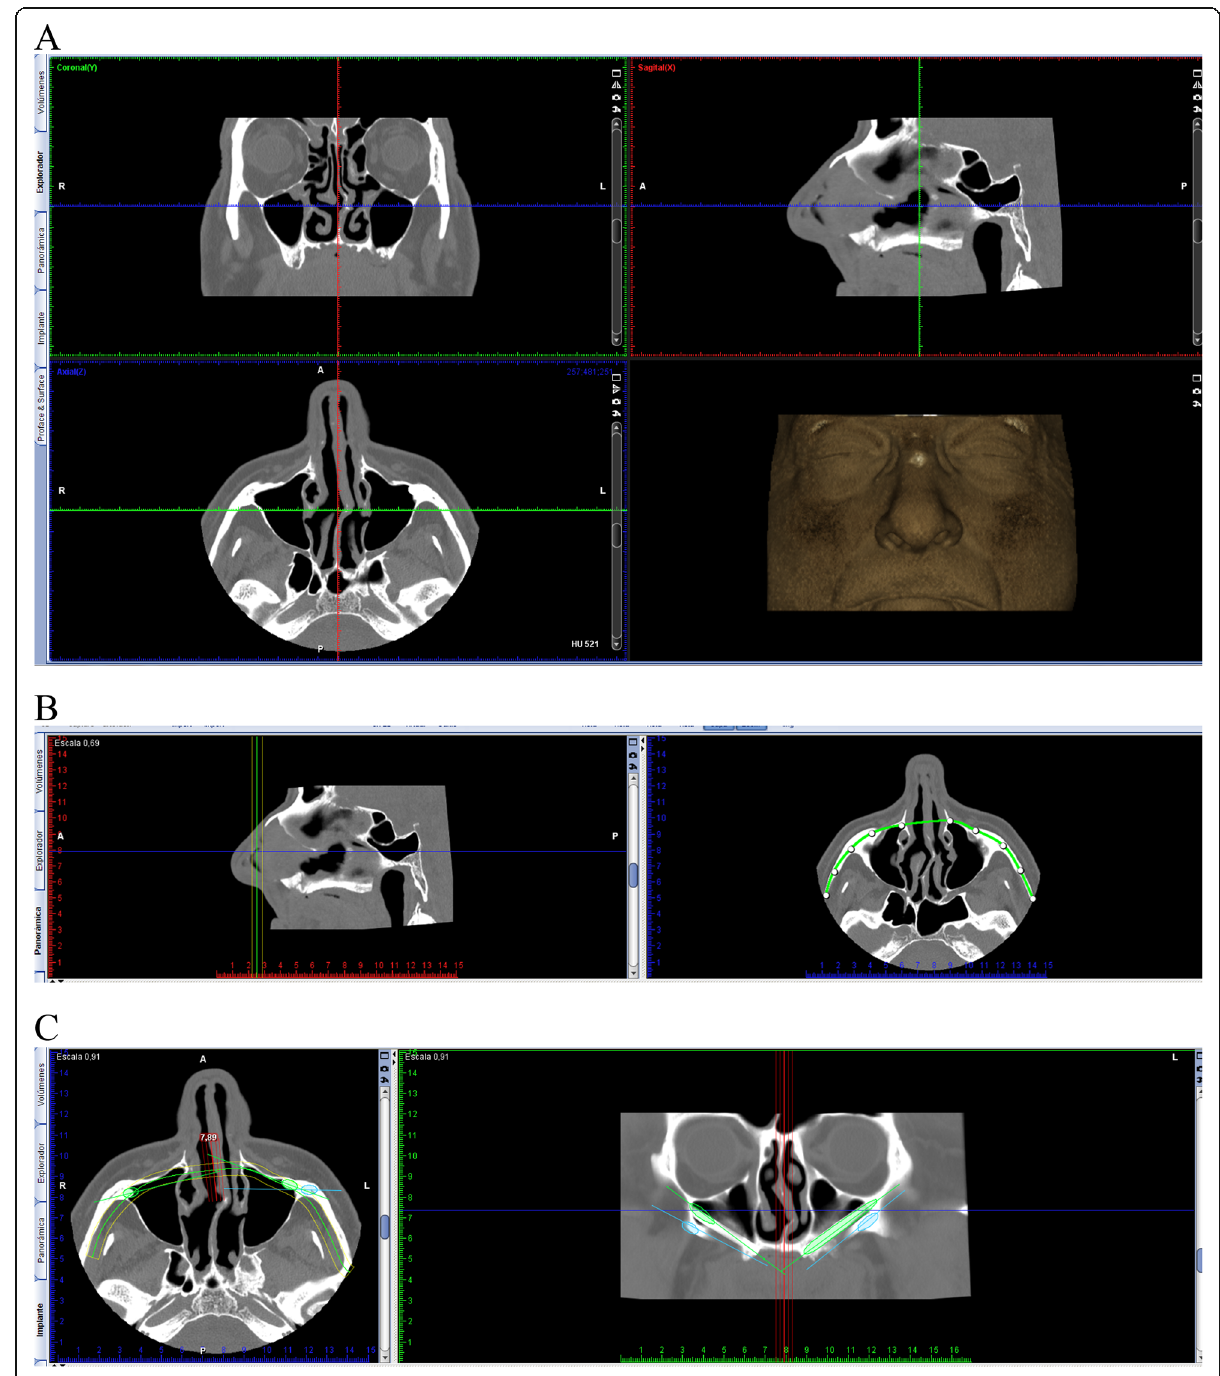
differences ( p < 0.05) for the apical ACD with respect to the implant position comparing VSP with the final position of the implants, but no other variable re- sulted in significant differences (Fig.